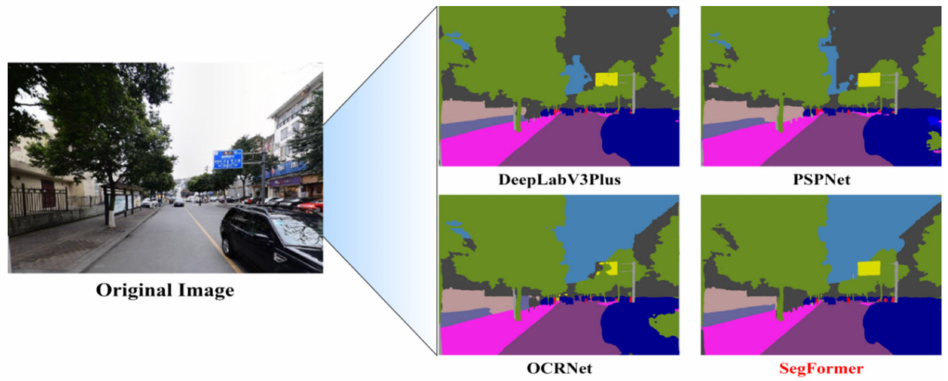
Figure 3. Results of different semantic segmentation algorithms.